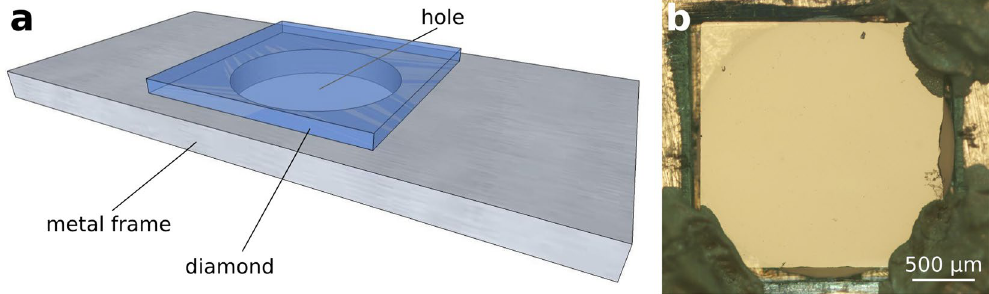
Figure 5. Sample schematics. ( a ) Schematic representation of the mounting of the thin diamond sample on a metallic frame; the drawing is not to scale. ( b ) Optical micrograph of the mounted sample in frontal